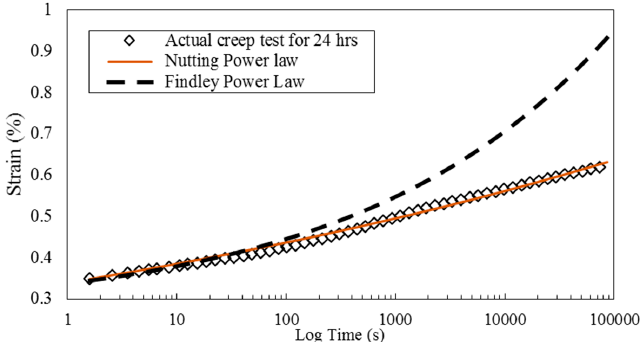
Figure 14. Comparison of extrapolated creep data with Nutting and Findley Power Laws with actual creep data for 24 h.